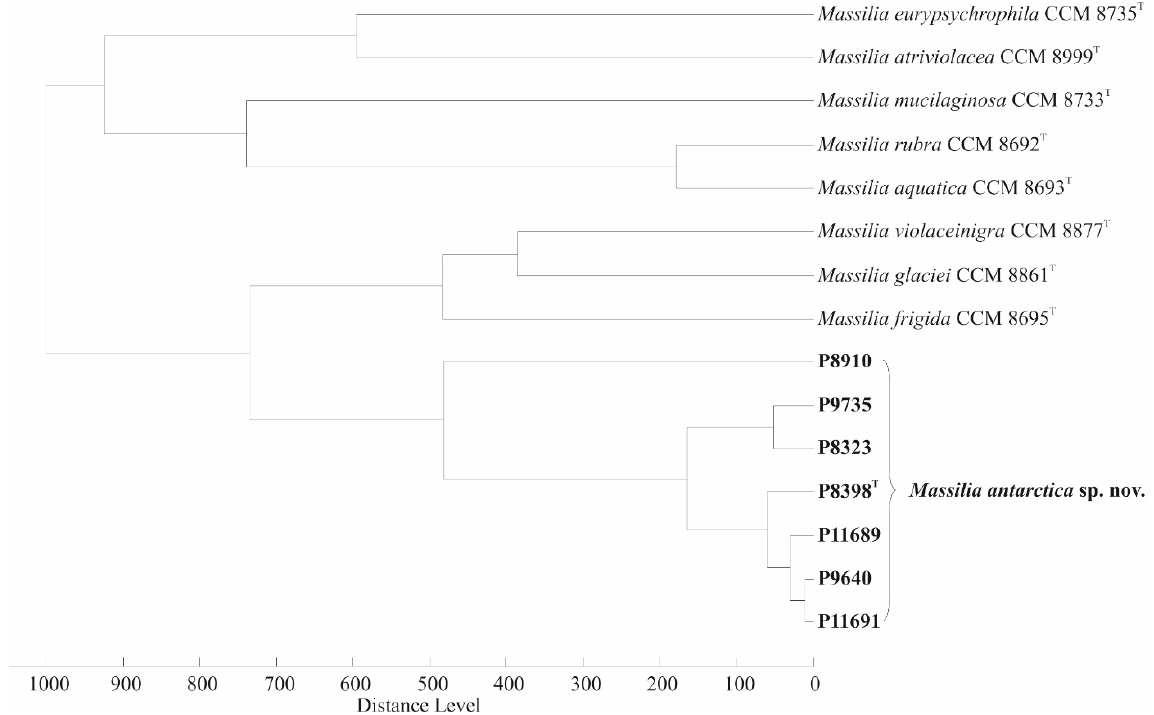
Figure 2. Dendrogram obtained by cluster analysis of MALDI-TOF mass spectra of M. antarctica sp. nov. isolates and the closest related Massilia spp. types, generated with Biotyper 3.0 software using Pearson’s product-moment coefficient as a measure of similarity and the unweighted pair group average linked method (UPGMA) as a grouping method. The distance is shown in relative units.